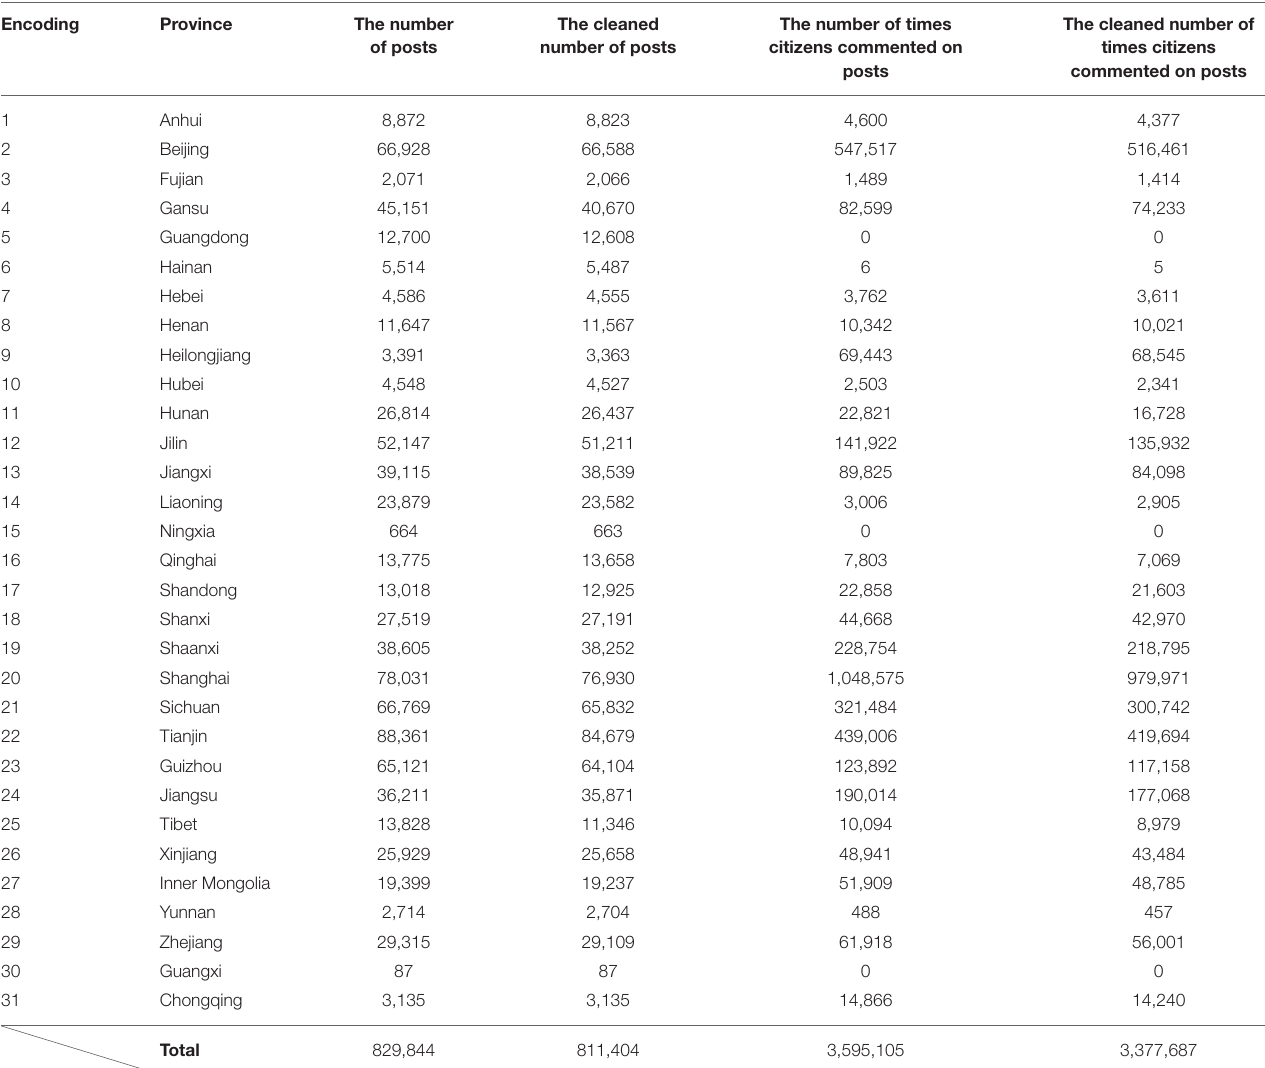
TABLE 1 | Summary of Weibo data collected from 31 Chinese provincial governments.